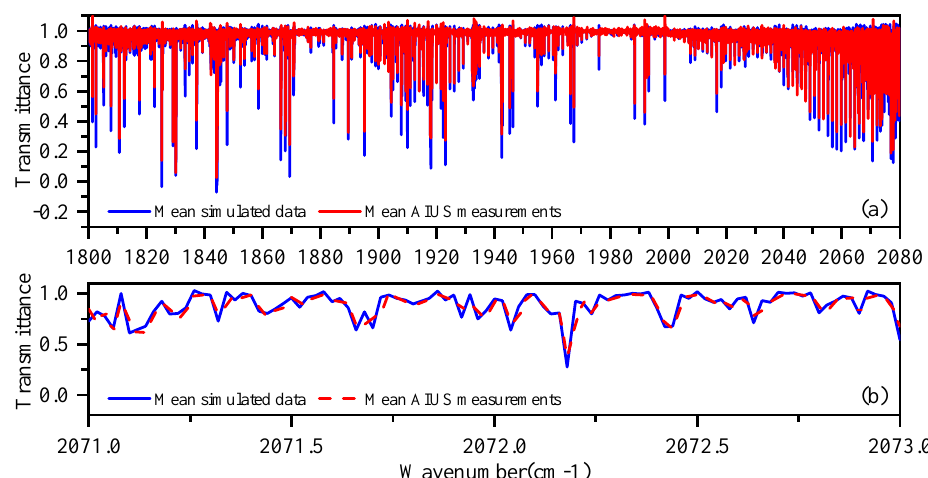
Figure A9. Mean transmittance of AIUS measurements and simulations in 1800–2080 cm − 1 at 40 km.